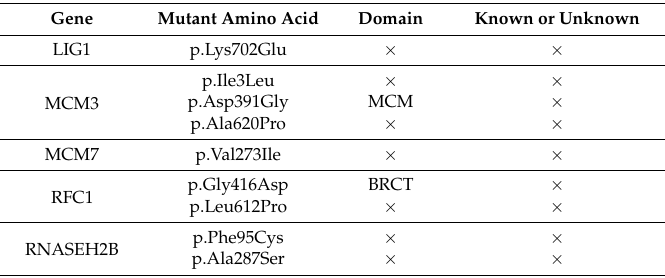
Table 2. Genes with polymerase-related amino acid